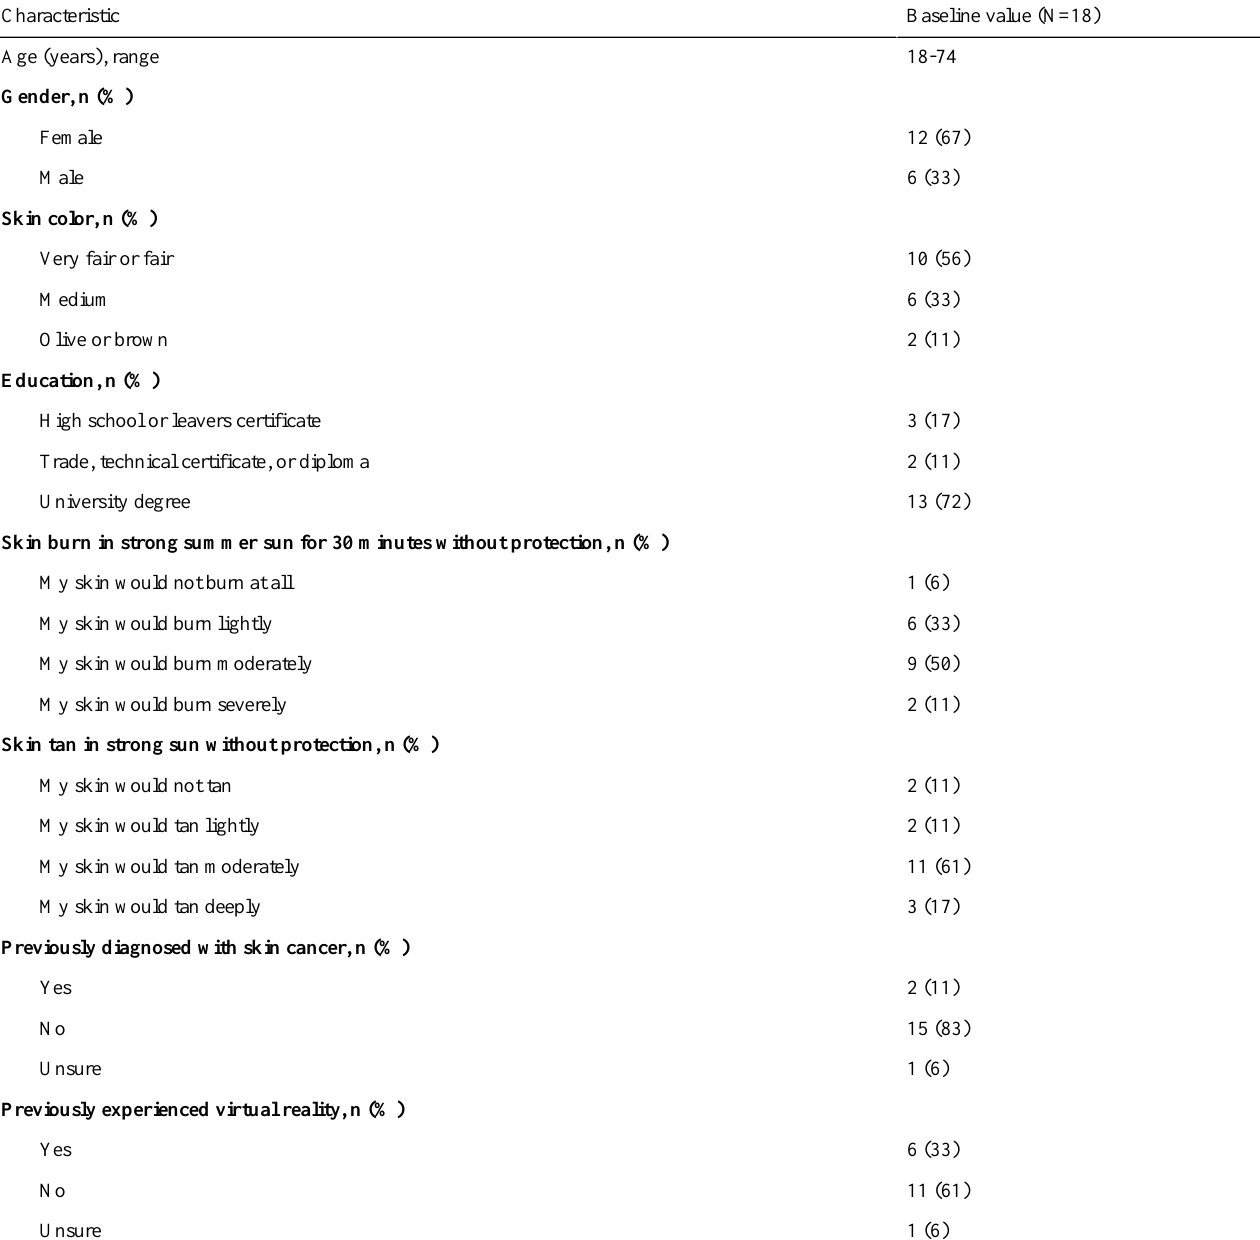
Table 1. End user focus group